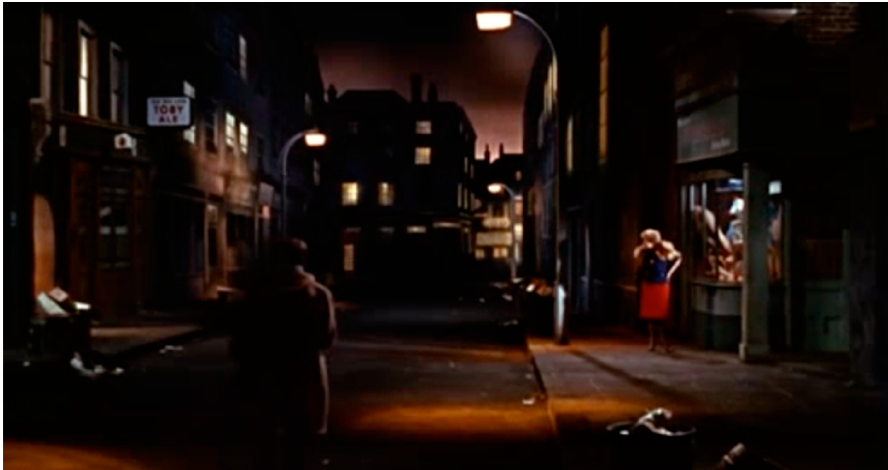
Figure 2. Image from Peeping Tom (1960) [25].